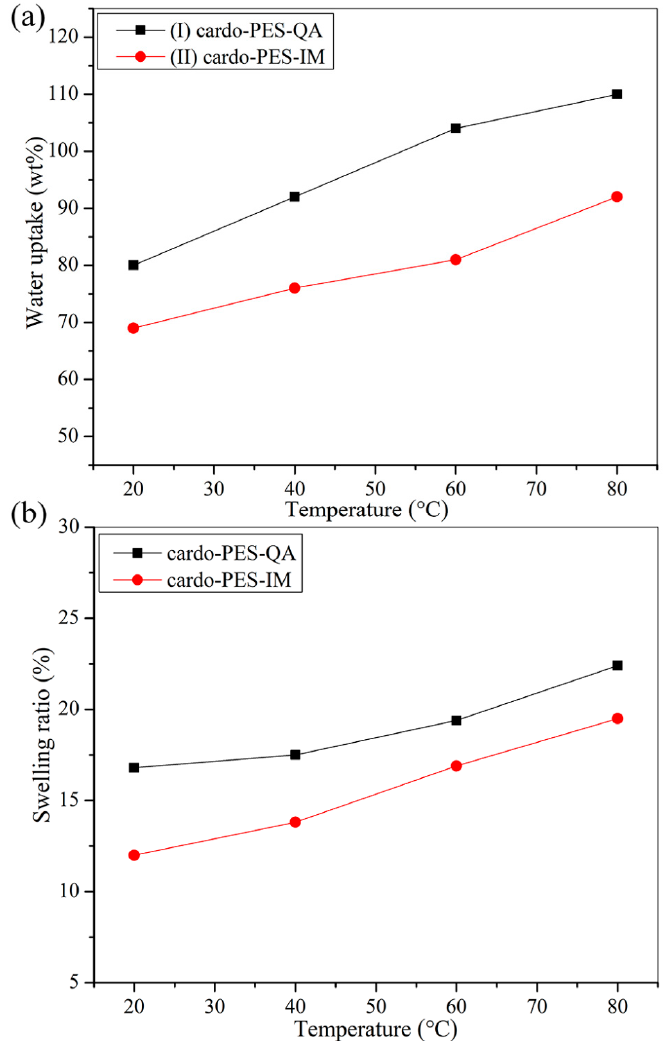
Figure 8. ( a ) Water uptake and ( b ) swelling ratio of the AEMs as a function of